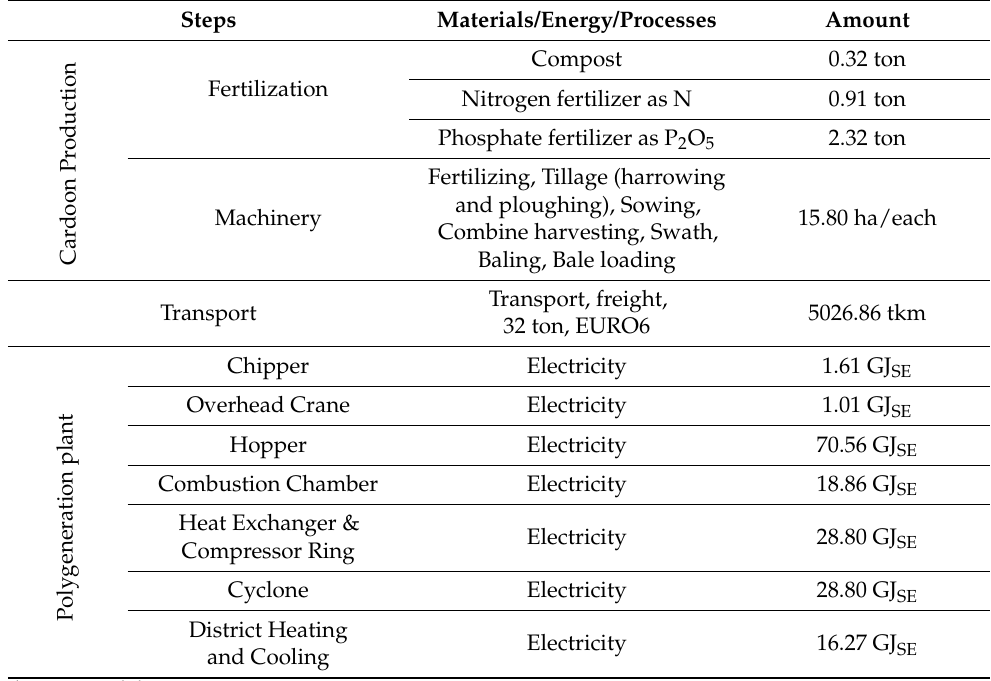
Table 1. Life cycle inventory—polygeneration chain. Steps